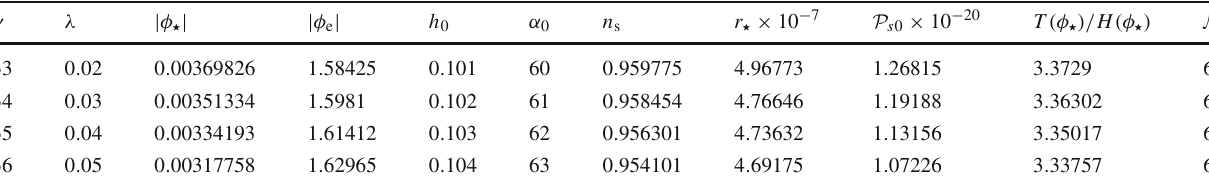
Table 2 Estimation of the free parameters of the non-comoving warm inflationary model in the weak dissipation regime with generalized de Sitter scale factors by using the Planck 2013, 2015 and 2018 data sets, and for C γ = 55. To obtain the presented values of the model param-